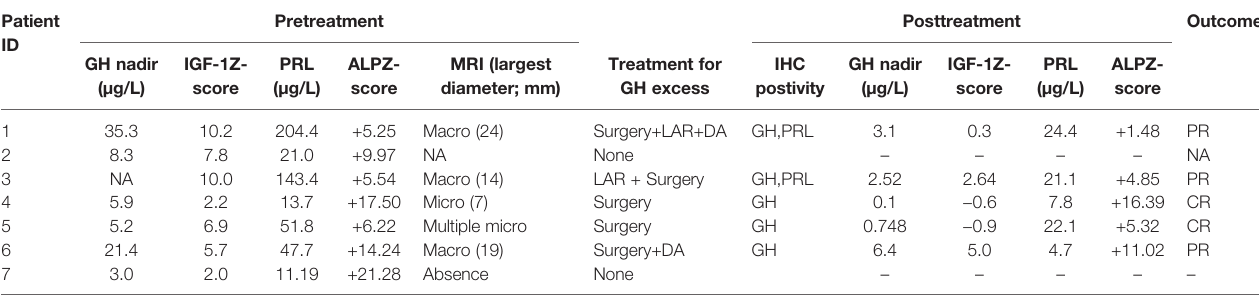
TABLE 3 | Clinical and biochemical characteristics and treatment outcomes of patients with GH excess and PP from PUMCH. Patient ID